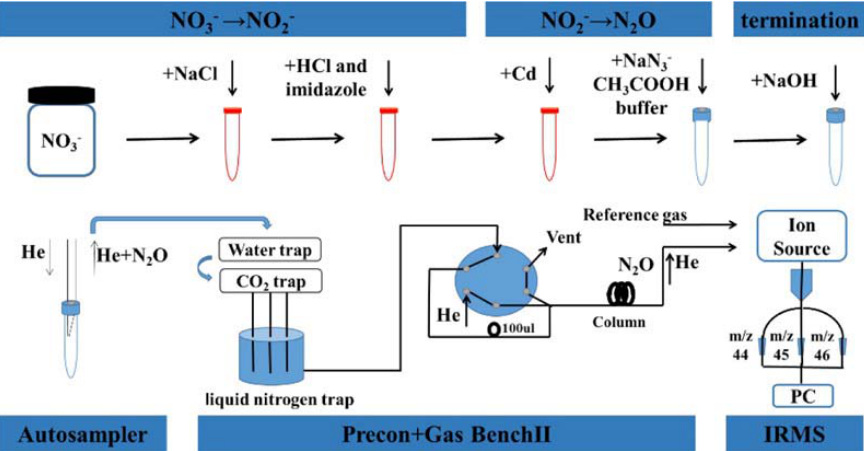
Figure 3. Schematic diagram of nitrate nitrogen and oxygen isotope analysis in atmospheric samples. Reprinted with permission from Ref. [34]. Copyright 2019 Elsevier.